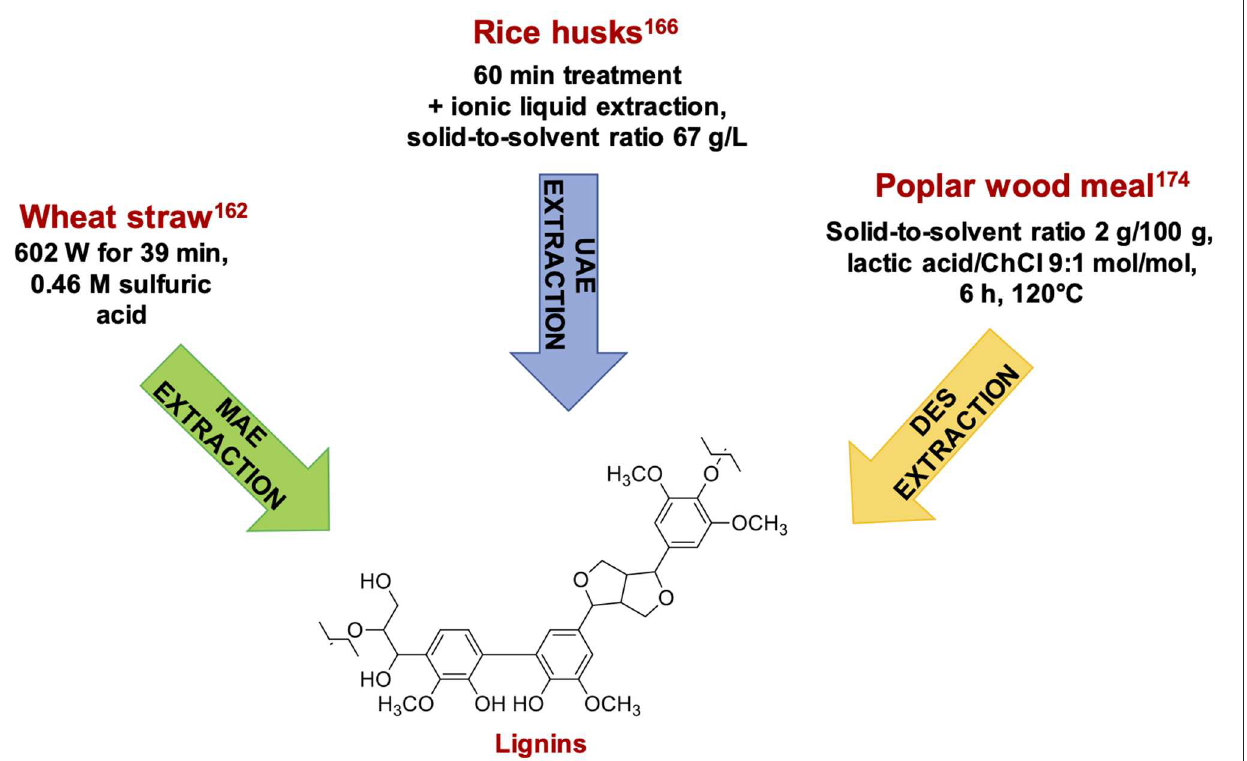
FIGURE 10 | Representative examples of phenolic compounds recovered from lignocellulosic byproducts.